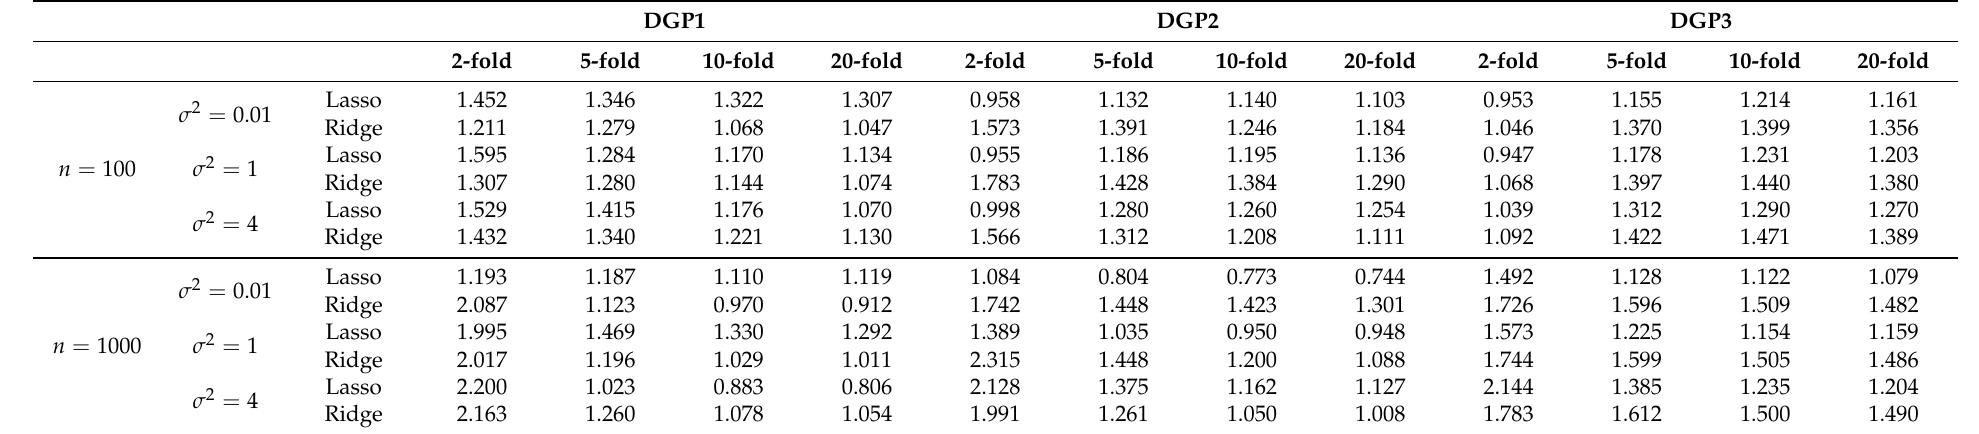
Table A3. Mean ratio of claimed SE and true SD: dependent predictors ( Σ 1 ) and constant coefficients.